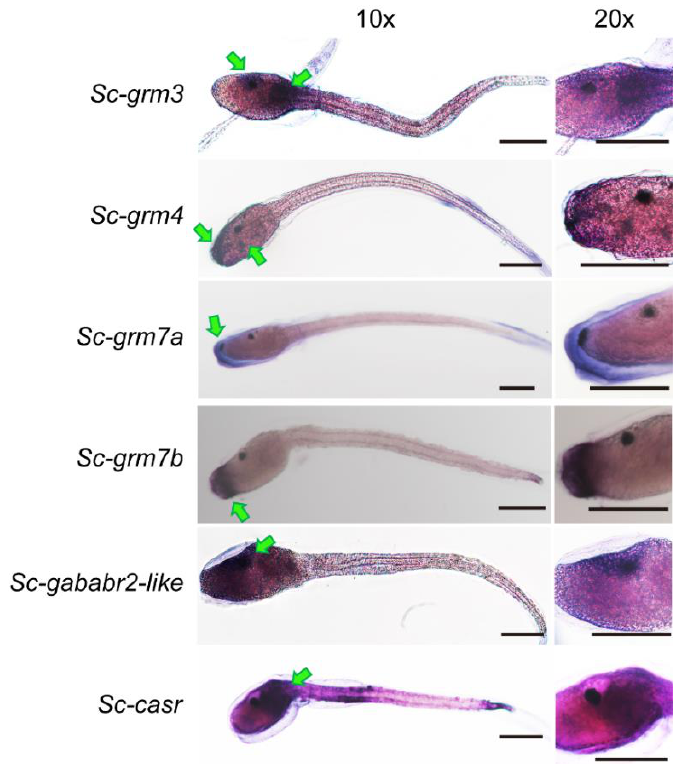
Figure 5. Whole-mount in situ hybridization of genes encoding S. clava Class C GPCRs in swimming larvae. Hybridized signals are distributed in the larval trunks and indicated by green arrowheads. The left and right panels indicate the same swimming larva for each gene observed under a microscope at 10× and 20× magnification, respectively. Scale bar: 100 μM. Negative controls with sense probe can be found in Figure S2.